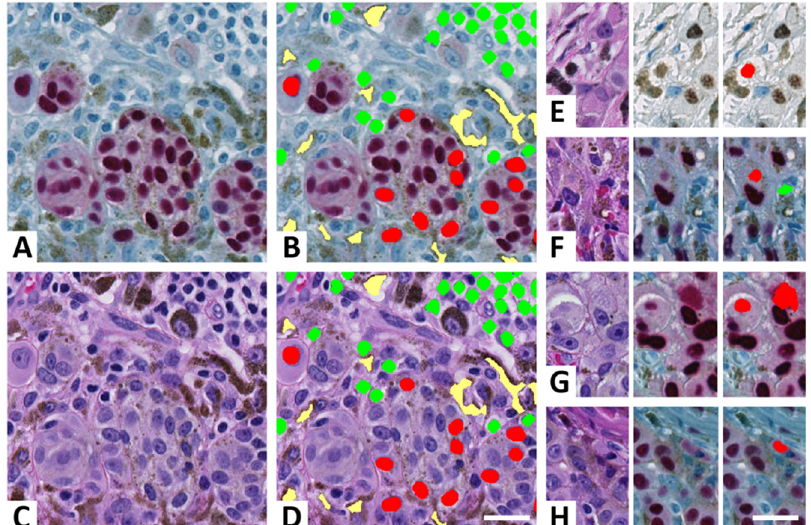
Figure 4. Automated annotation of digital H&E/SOX10 dual-stained melanoma. ( A ) SOX10-stained melanoma cells (red nuclei) and hematoxylin-stained normal cells (blue nuclei). Abundant melanophages are present (blue nucleus and brown melanin in cytoplasm). ( B ) Automated annotation of melanoma cells (red), normal cells (green), and remainder tissue (yellow) by CNN Ann-H&E-IHC . ( C ) H&E display of the same tissue area. ( D ) Annotations are directly transferred to H&E. ( E – H ) Errors of annotation using either thresholding of DAB stains ( E ) or CNN Ann-IHC on Fast-Red stains ( F – H ). By adding RGB input from both SOX10 and H&E in the CNN training, errors ( F – H ) were almost eliminated. ( E ) Melanin granules falsely annotated as a tumor-cell nuclei. ( F ) Unspecific red dot falsely annotated as a tumor-cell nucleus and erythrocyte falsely annotated as a normal-cell nucleus. ( G ) False annotation of an unspecific cytoplasmatic reaction and a somewhat dissolved nucleus (left). ( H ) Cytoplasm falsely annotated as tumor-cell nucleus. Scalebars, 25 µm. The difference in precision between CNN Ann-H&E/IHC and THR Red , the two best performing applications, was − 0.20% (95%CI, − 0.54% to 0.14%; p = 0.3) for tumor cells and − 1.1% (95%CI, % − 2.5% to 0.29%; p = 0.2) for normal cells. The difference was